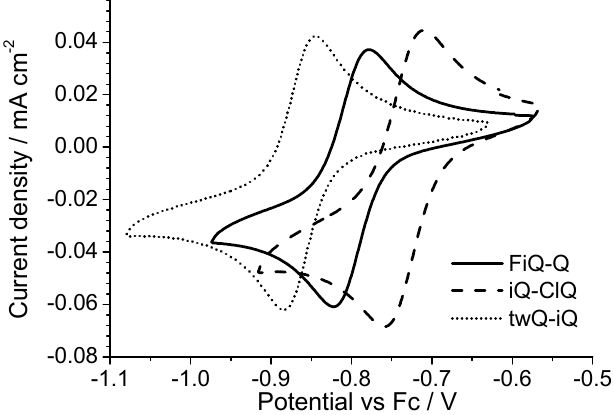
Figure 6. Cyclic voltammograms of derivatives FiQ-Q (F-substituent on the isoquinolinic ring), iQ-ClQ (Cl-substituent on the quinolinic ring), and twQ-iQ.